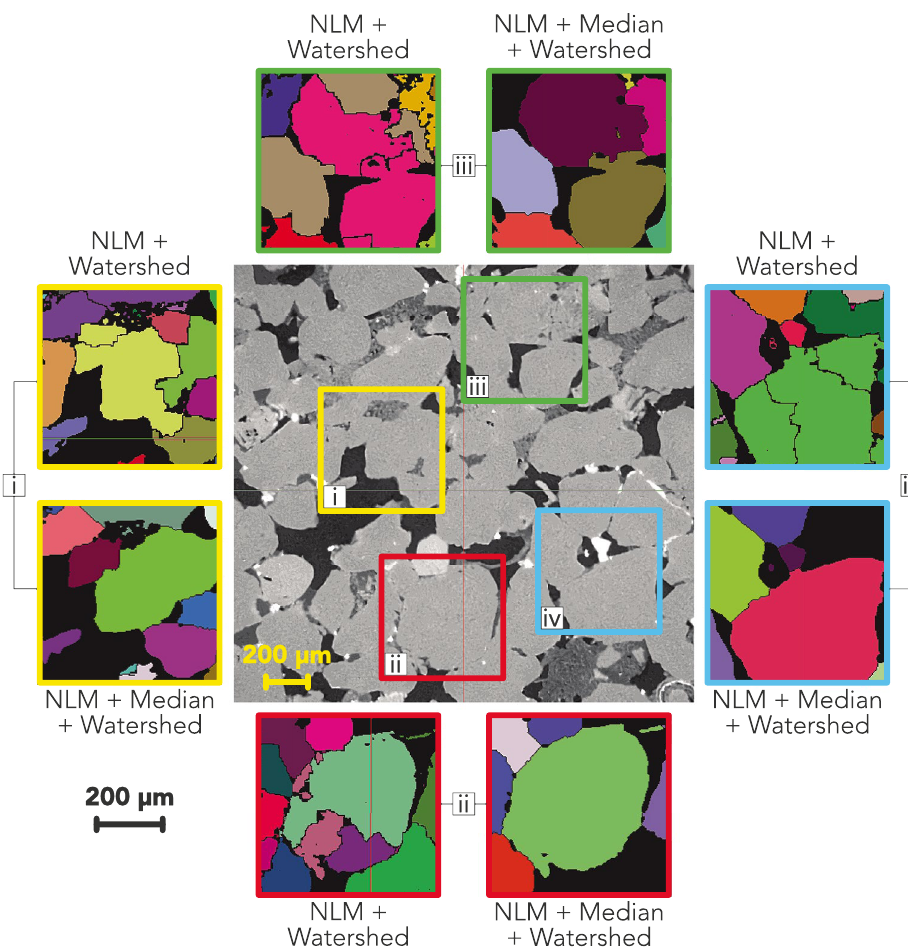
Figure 6. Comparison of two different filtering techniques’ effects on the watershed algorithm in a single slice of sample PB10. Four different locations have been highlighted for comparison on an image which has undergone non-local means (NLM) filtering only. Annotated squares show the result of watershed grain segmentation following only NLM 32 and NLM with a median filter 31 . Each grain can be identified by a different colour however, due to the number of grains, colours have been reused and instead the black grain boundaries split different grains of the same colour. In each annotation an example of over-segmentation is observed in the case of using NLM filtering only when compared to what might be expected from the CT image. The outer scale bar applies to all annotations. Figure created using Fiji 2.1.0 42 and PerGeos 1.7.0: https:// www. therm ofish er. com/ uk/ en/ home/ elect ron- micro scopy/ produ cts/ softw are- em- 3d- vis/ perge os- softw are.